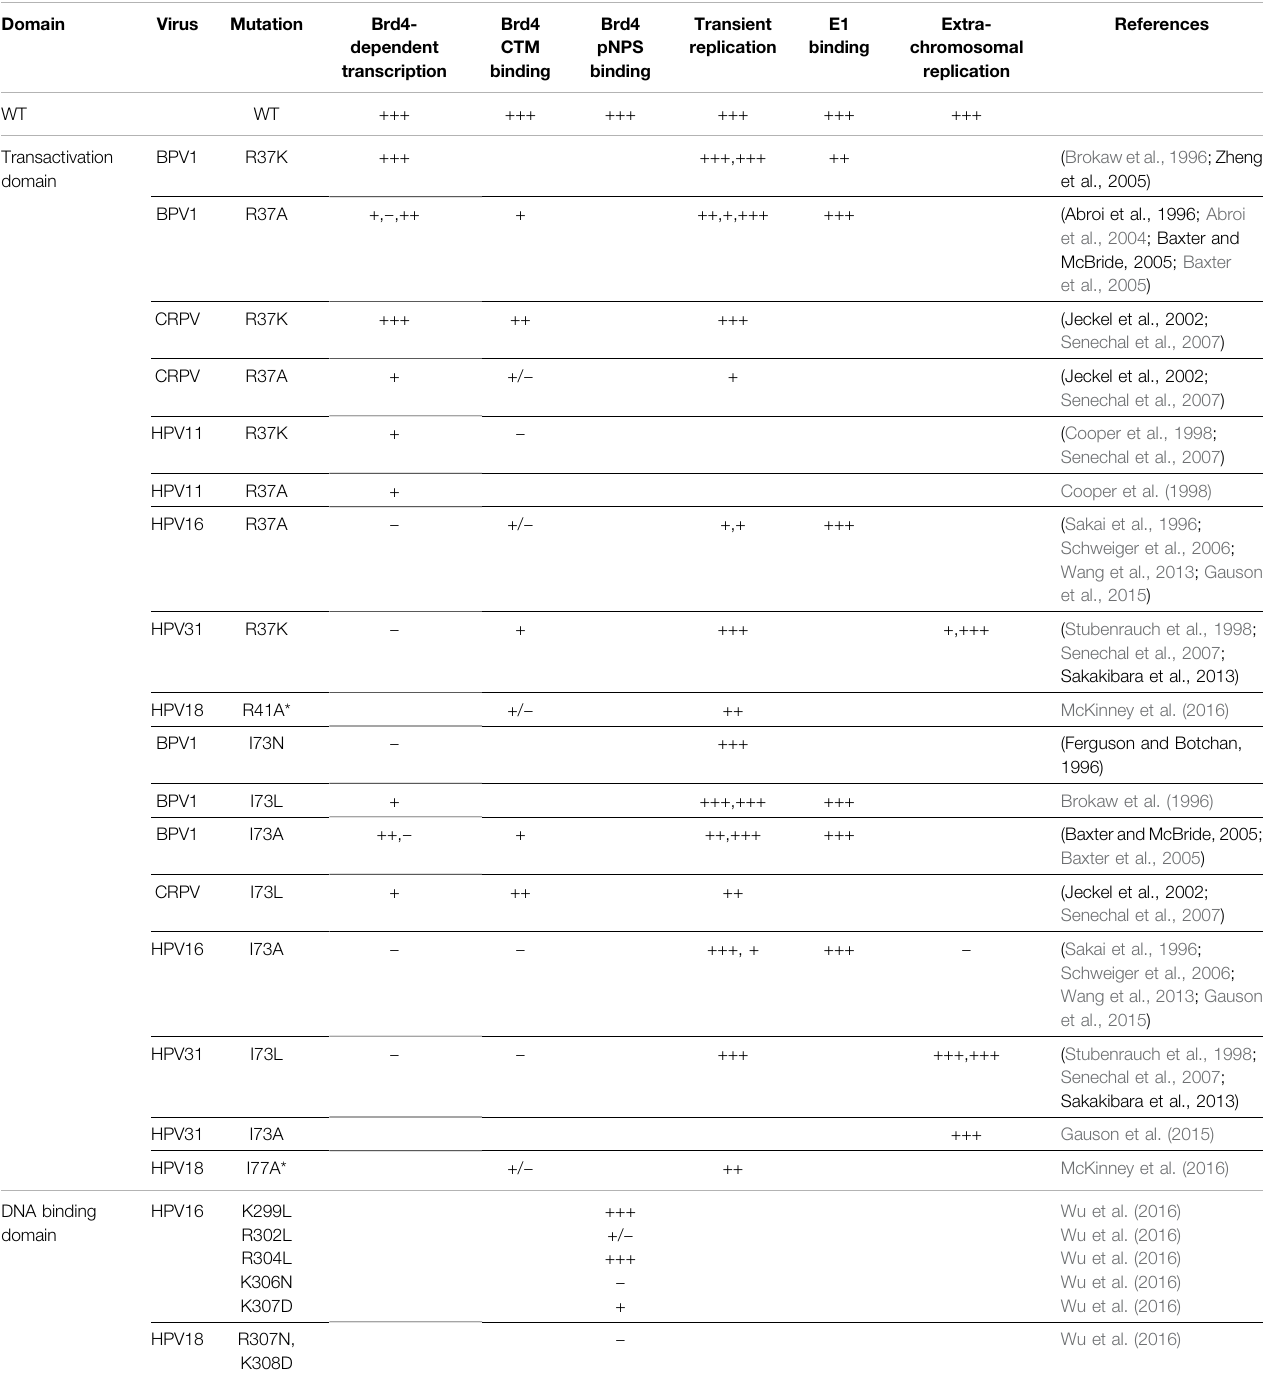
TABLE 1 | Phenotypes of Papillomavirus E2 Mutations that Affect Brd4 Binding.